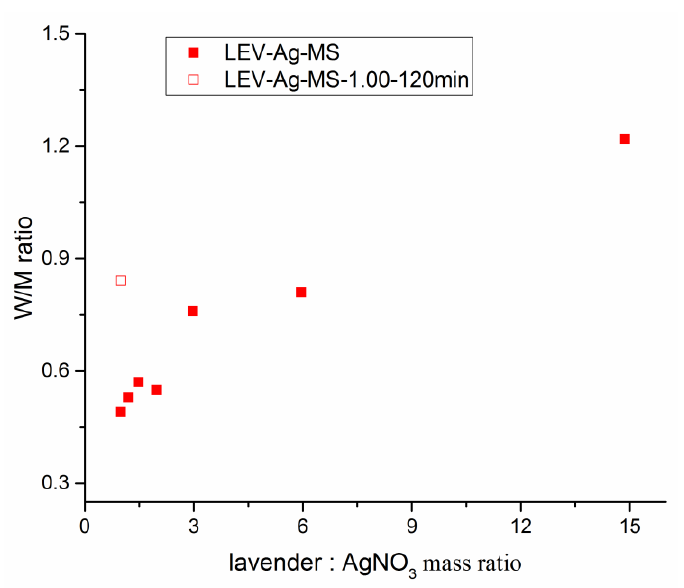
Figure 4. The dependence of W/M ratio determined from atomic absorption spectrometry on lavender:AgNO 3 mass ratio used in the mechanochemical synthesis.